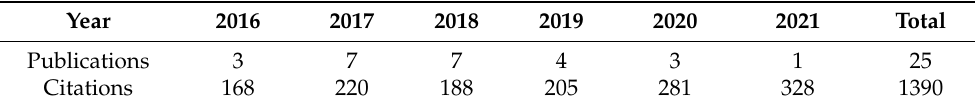
Table 5. Publication and citation counts based on the analysis pattern: TS = ((natural gas) AND energy security educ*). Source: Web of Science database.